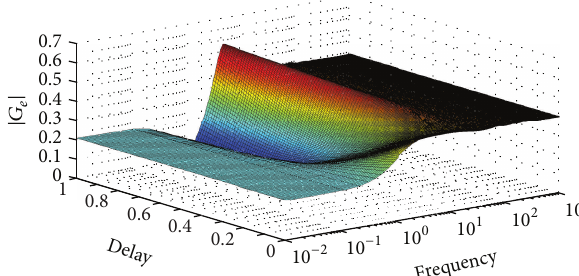
Figure 5: The relationships among frequency, delay, and conver- gence speed for the ILC scheme (45) and